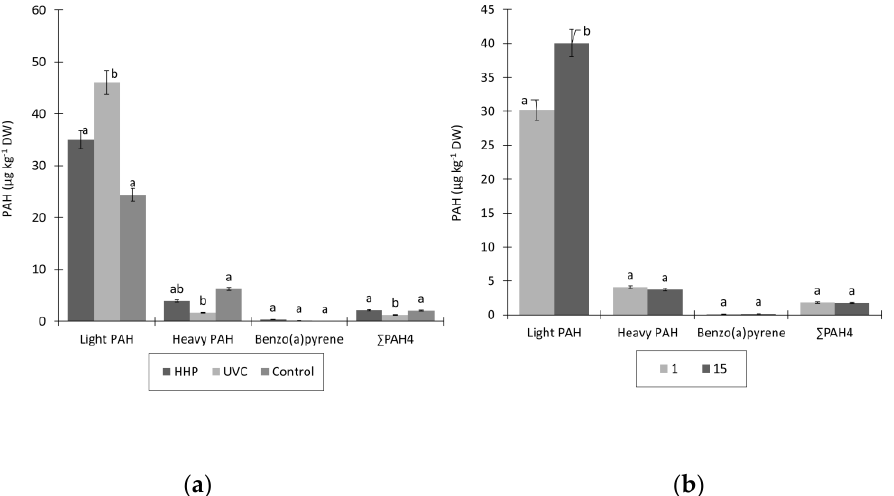
Figure 5. PAH content ( µ g kg − 1 DW) in ( a ) control, UV-C-, and HHP-treated fried fresh-cut potatoes at ( b ) 1st and 15th day of storage. Results are expressed as least square (LS) means. Different letters within columns mean statistically different values at p ≤